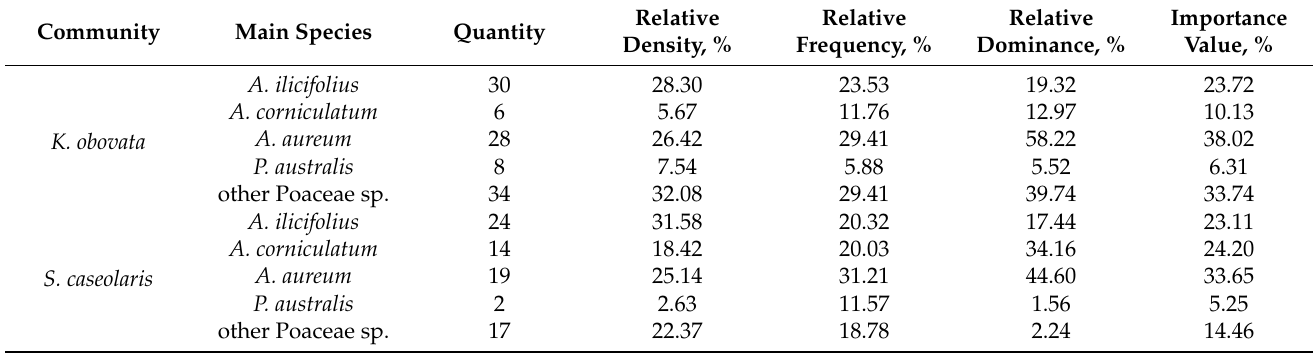
Table 3. Importance values of the shrub-grass layer in the K. obovata and S. caseolaris communities on the west coast of Bao’an,